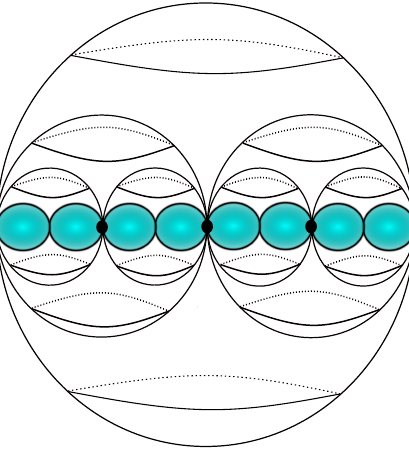
Figure 16. Homeomorphic representation of the union of the levels of DT.